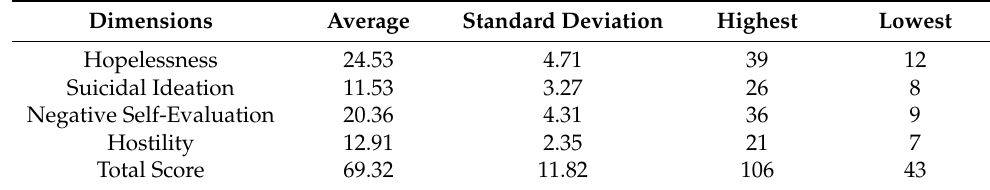
Table 3. Suicide possibility scale